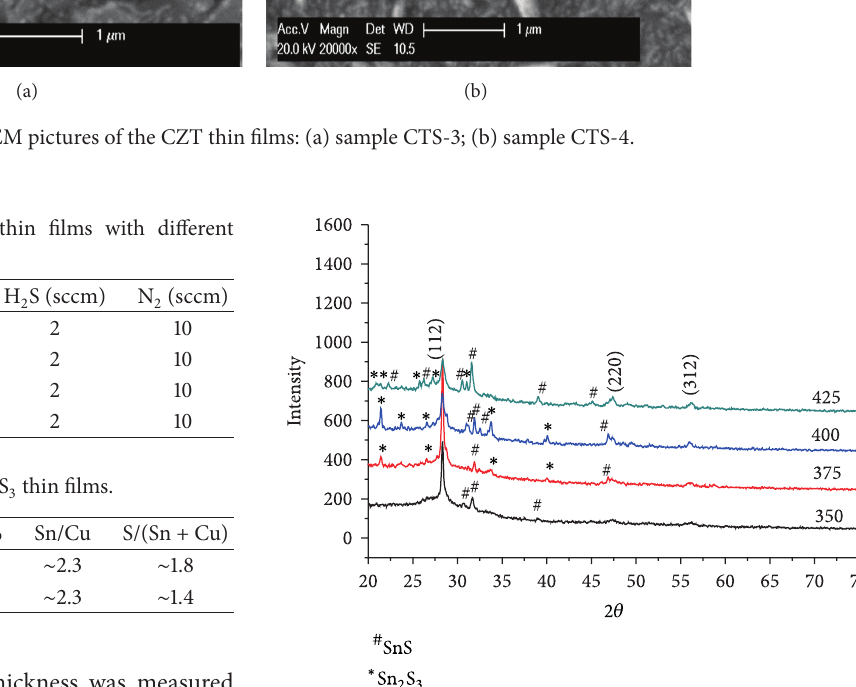
Figure 2: XRD patterns of the CTS thin films prepared at different sulfurization